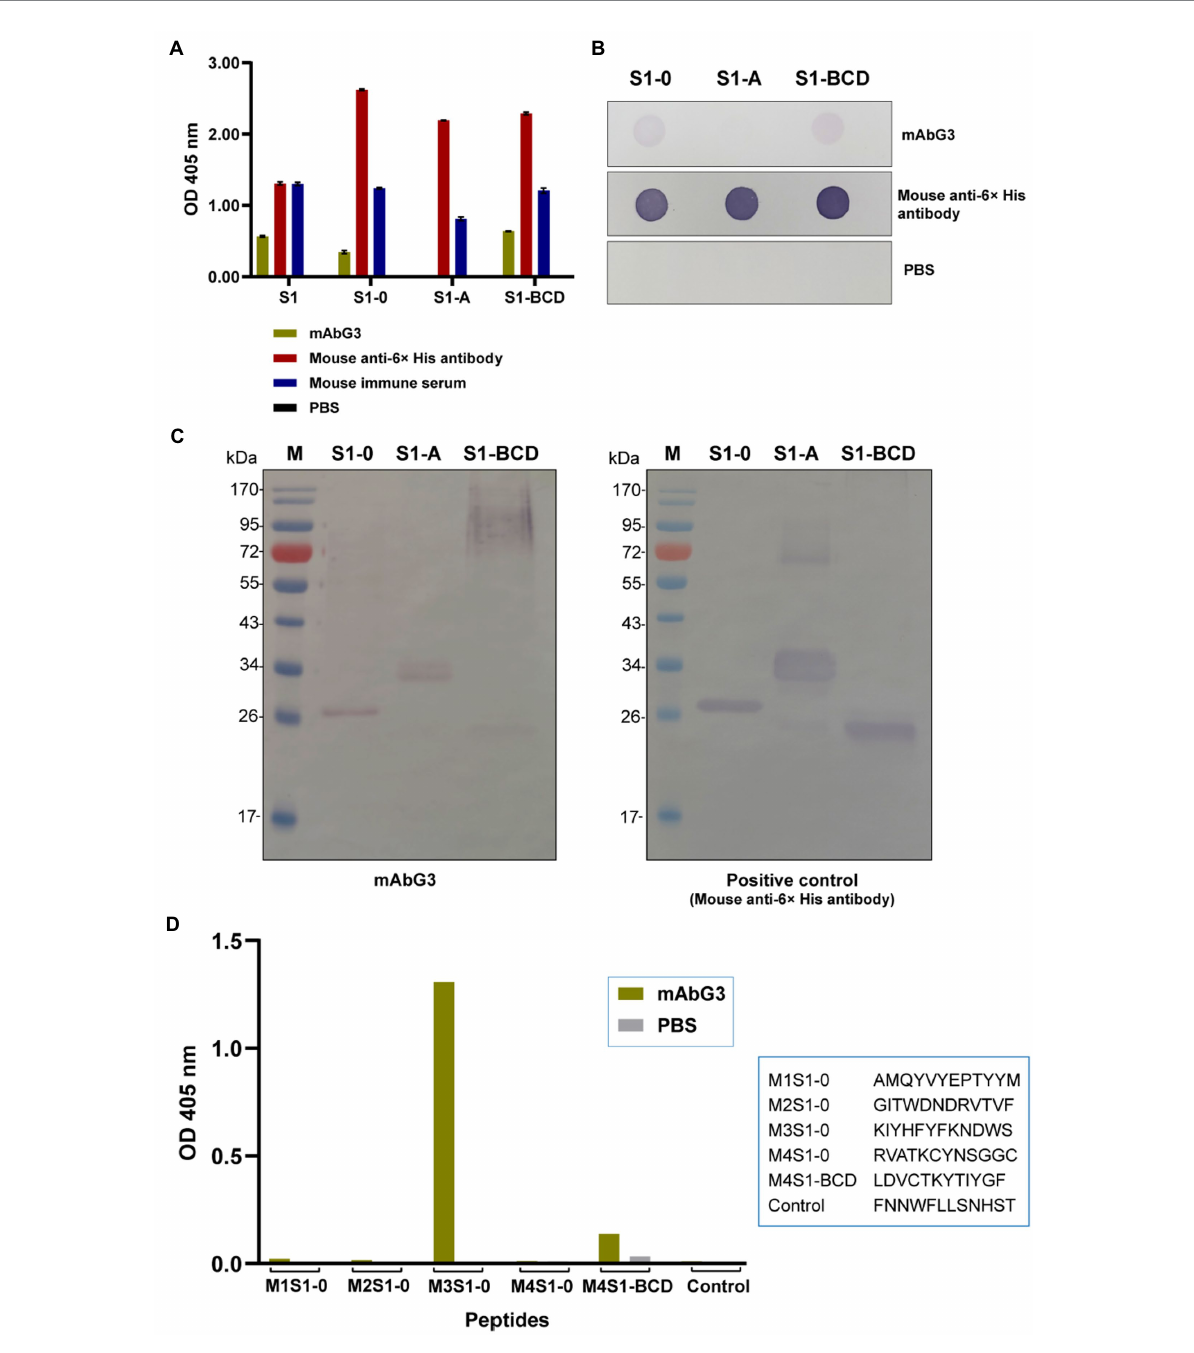
FIGURE 4 Binding of mAbG3 to recombinant polypeptides S1-0, S1-A, and S1-BCD of the PEDV S1 subunit. (A) Indirect ELISA (OD 405 nm) of mAbG3 binding to the full-length recombinant S1 subunit and the S1 polypeptides S1-0, S1-A, and S1-BCD. Mouse anti-6× His antibody and mouse immune serum (1:10,000) served as positive binding controls, and PBS served as a negative binding control. (B) Binding of mAbG3 to S1-0, S1-A, and S1- BCD by dot ELISA. Mouse anti-6× His antibody (1:1,000) and PBS served as positive and negative binding controls, respectively. (C) Binding of mAbG3 to SDS-PAGE-separated S1-0, S1-A, and S1-BCD by Western blotting (left panel). Mouse anti-6× His antibody (1:1,000) was used as a positive control (right panel). (D) Binding of mAbG3 to M1S1–0, M2S1–0, M3S1–0, M4S1–0, M4S1-BCD, and control peptides by peptide binding ELISA. Y-axis, OD 405 nm; X-axis, peptides used as the test antigens; PBS served as